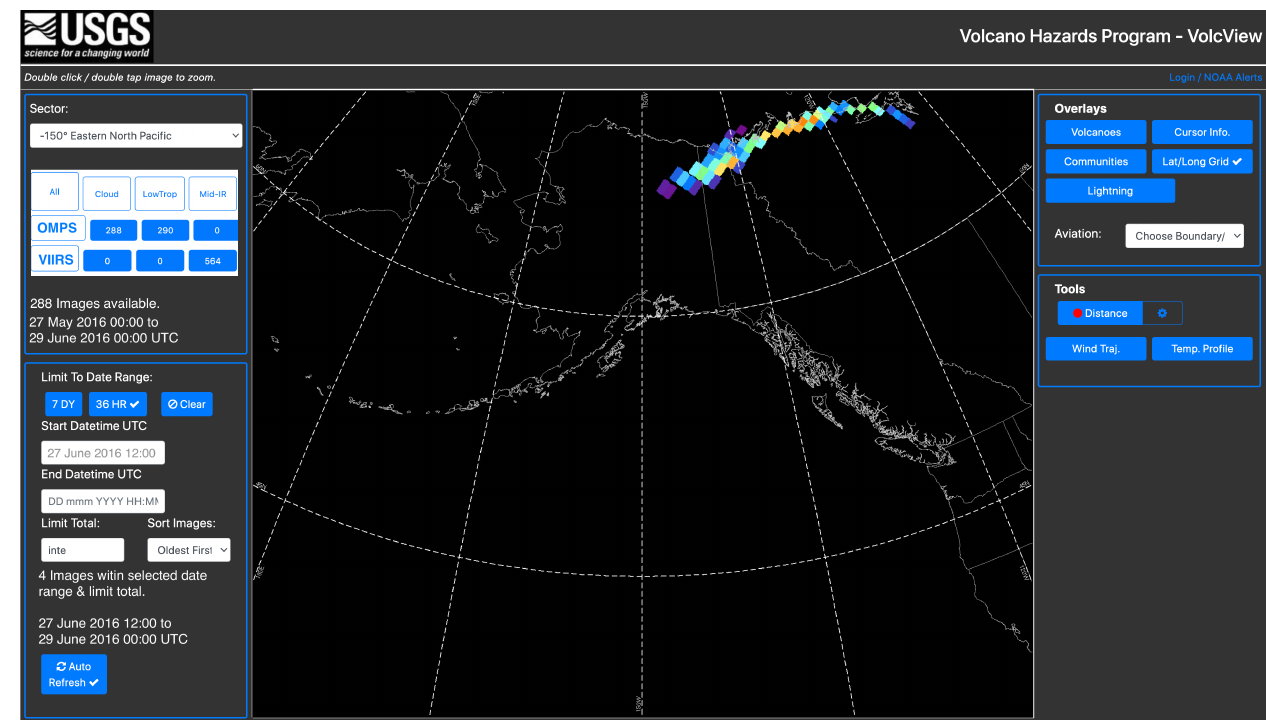
Figure 9. Direct readout SNPP/OMPS SO 2 data for the March 2016 Mount Pavlof eruption integrated into the AVO VolcView Decision Support Tool (DST) (https://volcview.wr.usgs.gov/vv-gui/ accessed on 5 October 2021). VIIRS TIR SO 2 data are ingested into this DST at AVO and A-VAAC for nighttime